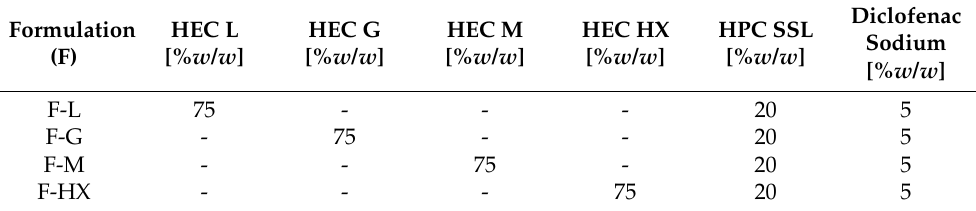
Table 1. Composition of different investigated pharmaceutical formulations (F). HEC = Hydroxyethyl cellulose, HPC = Hydroxypropyl cellulose; L, G, M, HX = different Mw grades of HEC, SSL = Mw grade of